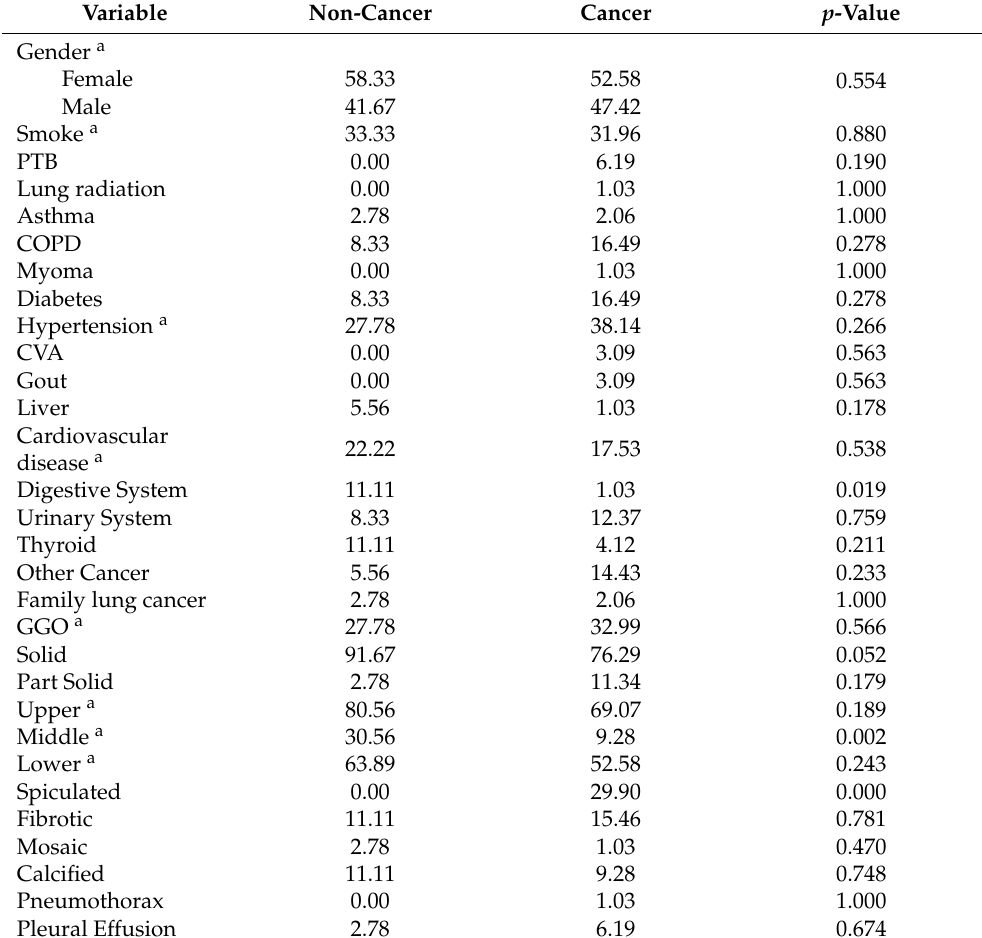
Table 4. The proportion of the binary variables coded as 1 in the cancer and non-cancer groups, and the p -values of the tests for independence. Among these binary variables, having diseases related to the digestive system, nodules in the middle lobe, and spiculated nodules were significant to lung